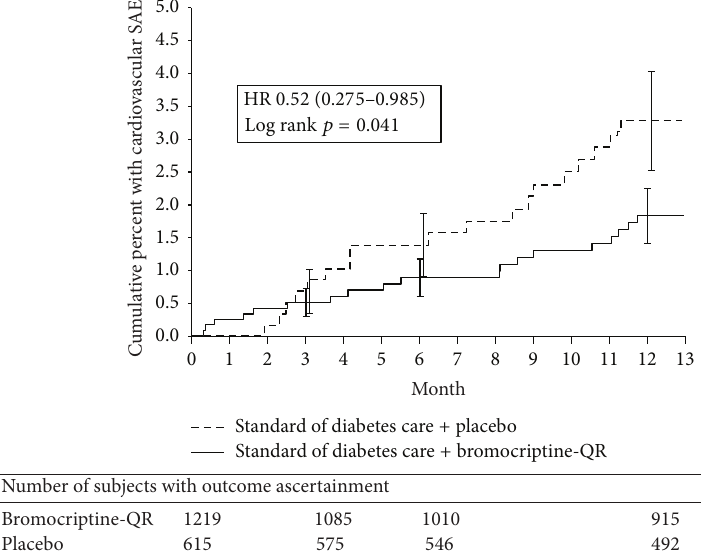
Figure 2: Kaplan-Meier estimates of the proportion of subjects by treatment that experienced an event within the composite CVD endpoint.